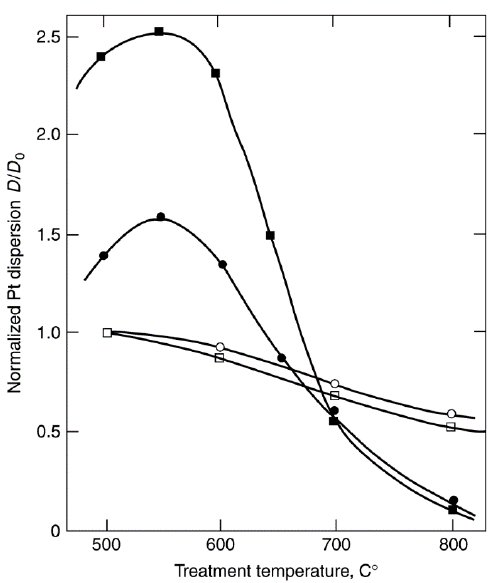
Figure 47. Effects of 1-h treatments in O 2 (closed symbols) and H 2 (open symbols) on the dispersion of Pt/Al 2 O 3 catalysts: ○,● Pt/Al 2 O 3 (Engelhard), □,■ Pt/KA-201 alumina (Kaiser). Reproduced from [102]. Copyright 1982, Brill Nijhoff